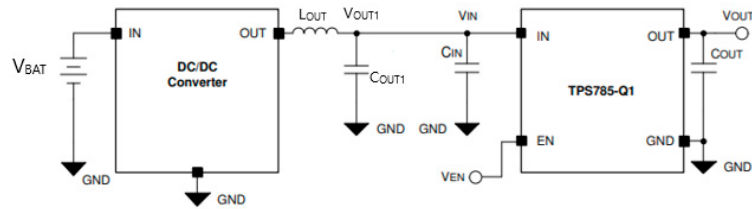
Figure 3. Typical application for the TPS785-Q1 voltage regulator [14].